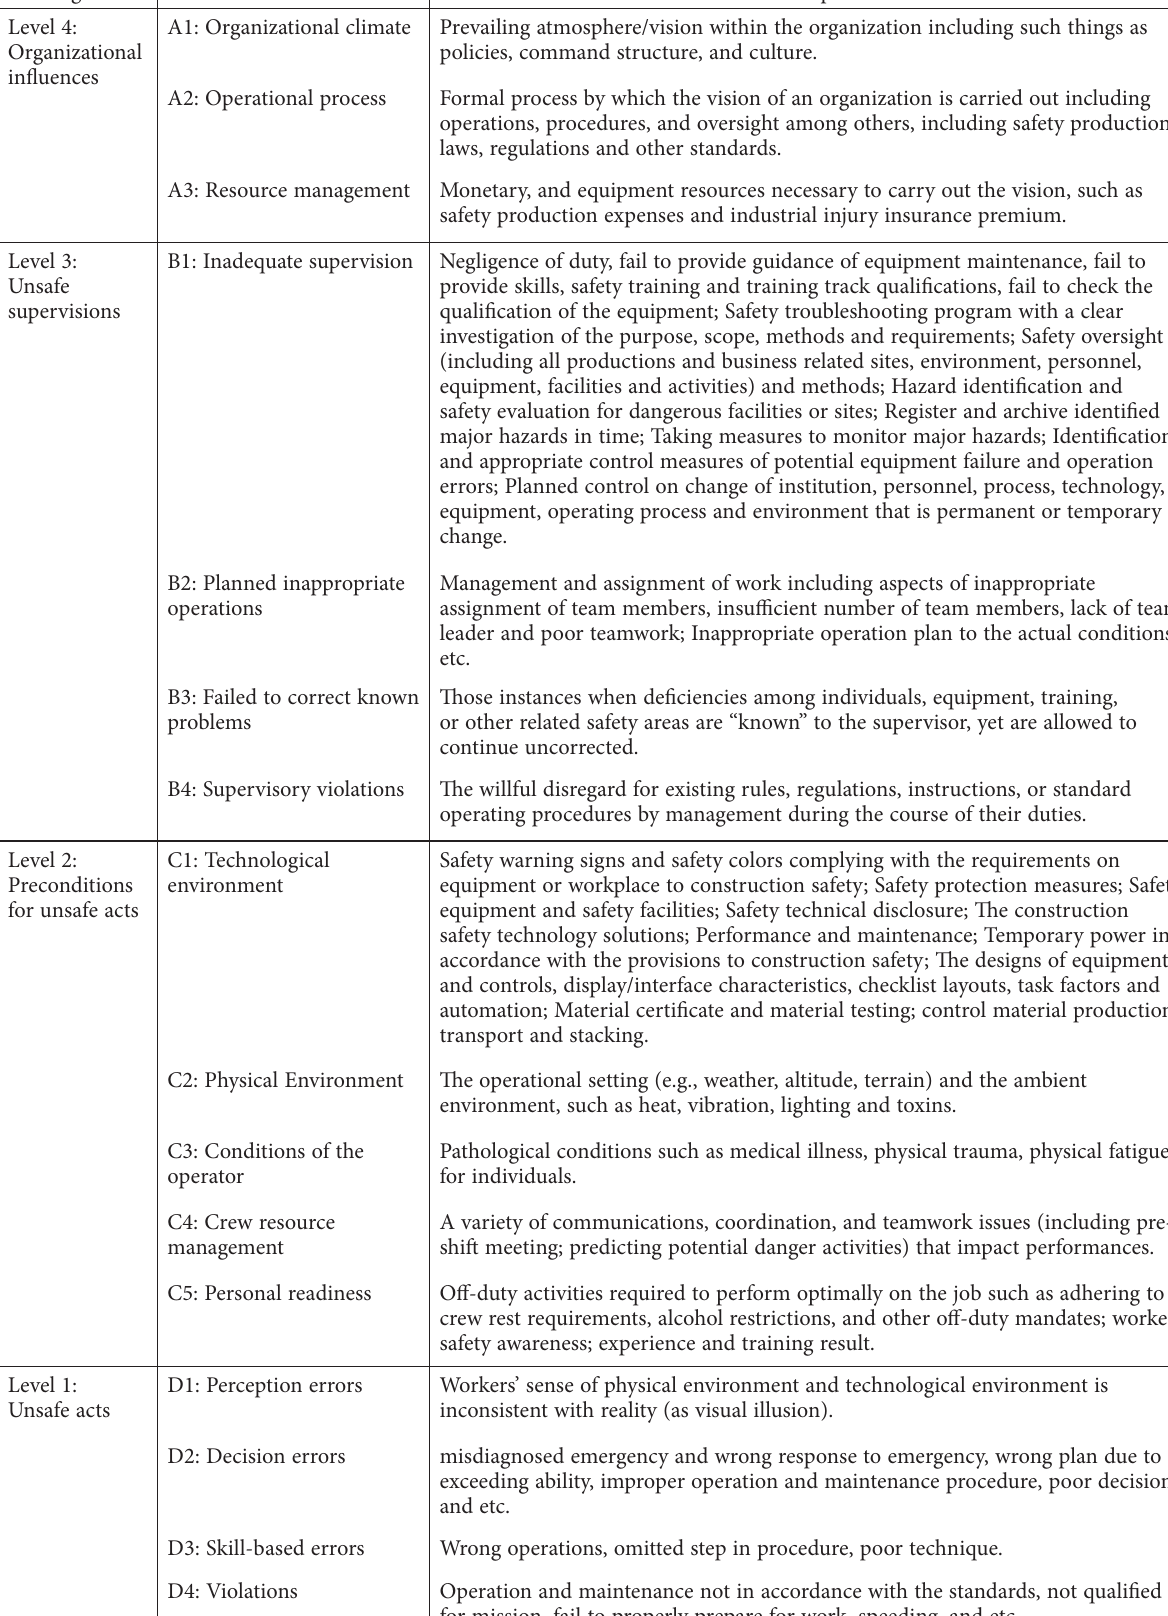
Table 1. Brief description of HFACS causal